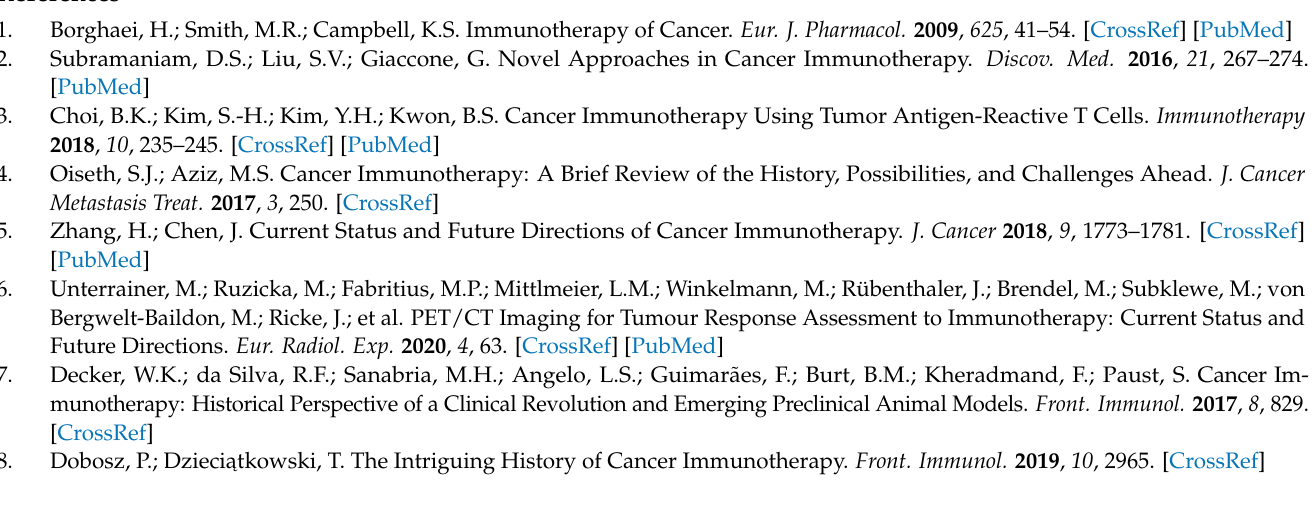
Table S3: Summary table demonstrating previous observations from the utilization of CAR-T in Non-Hodgkin’s